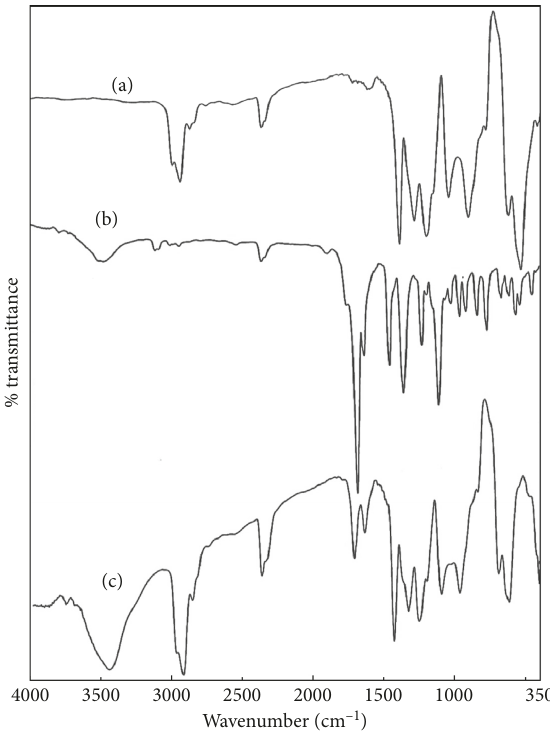
Figure 2: FTIR spectra of PVC modified by N -(4-BrPh)IM (c) as compared to N -(4-BrPh)IM monomer (b) and PVC